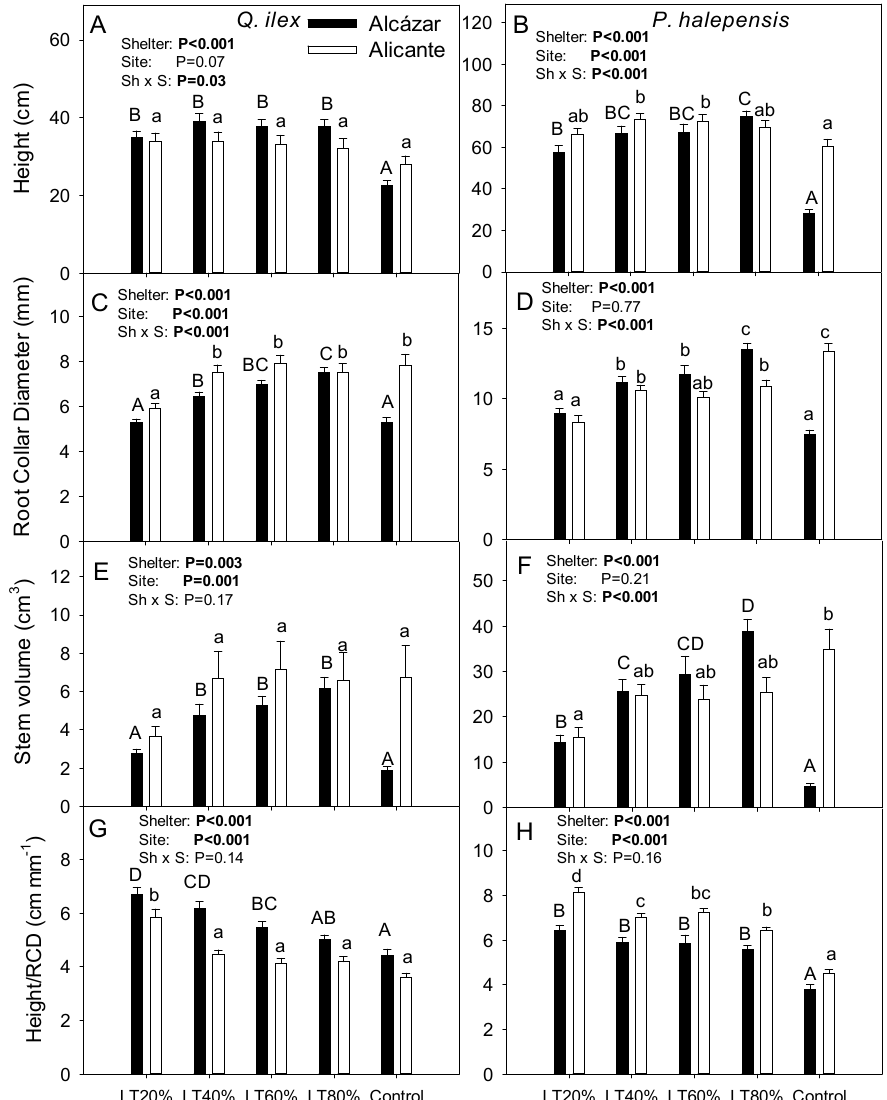
Figure 2. Mean values ( n = 35–45) of morphological traits at the end of the second season year (No-